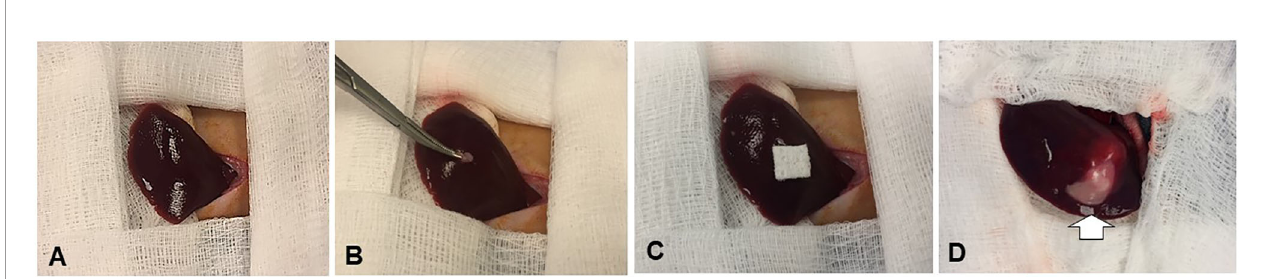
FIGURE 2 | Creation of the New Zealand white rabbit models with orthotopic liver VX2 tumors. An approximately 1-mm 3 minced VX2 tumor is directly implanted into the subcapsular area of the left lobe of the liver by ophthalmic bend tweezers (A, B) , followed by 5-min manual compression of the tumor injection site with a gelatin sponge (C) . Two weeks later, the tumors are created [arrow on (D)